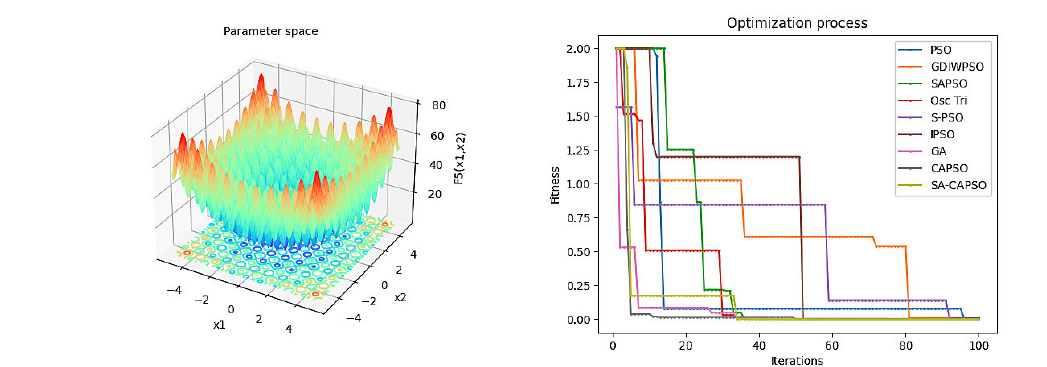
Figure 7. Two-dimensional function image and iterative curve of function F4.